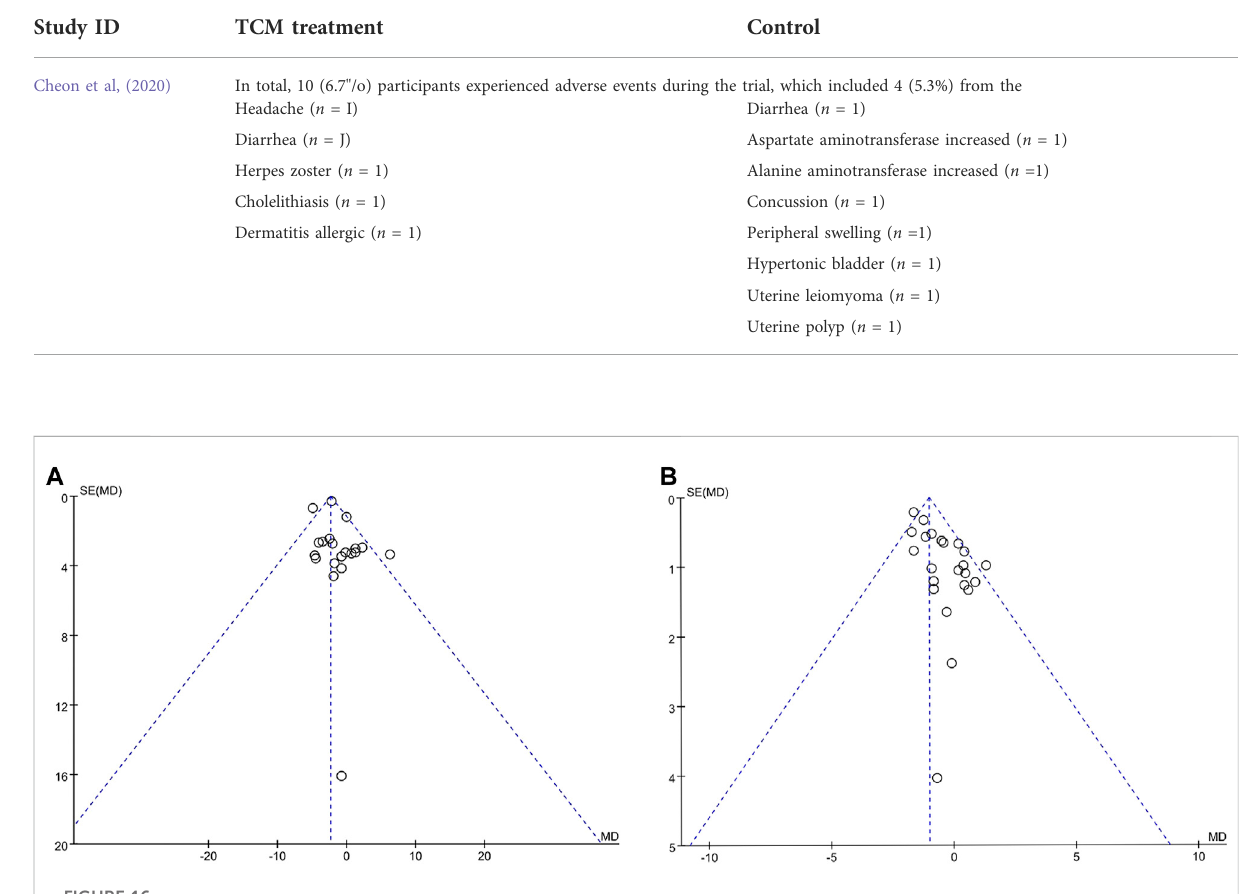
FIGURE 16 Funel plotofpublication bias.Comparison:TCMtreatment placeoorblankcontrol. (A) Funel plotinpublication biasinweight. (B) Funel ploton publication bias in